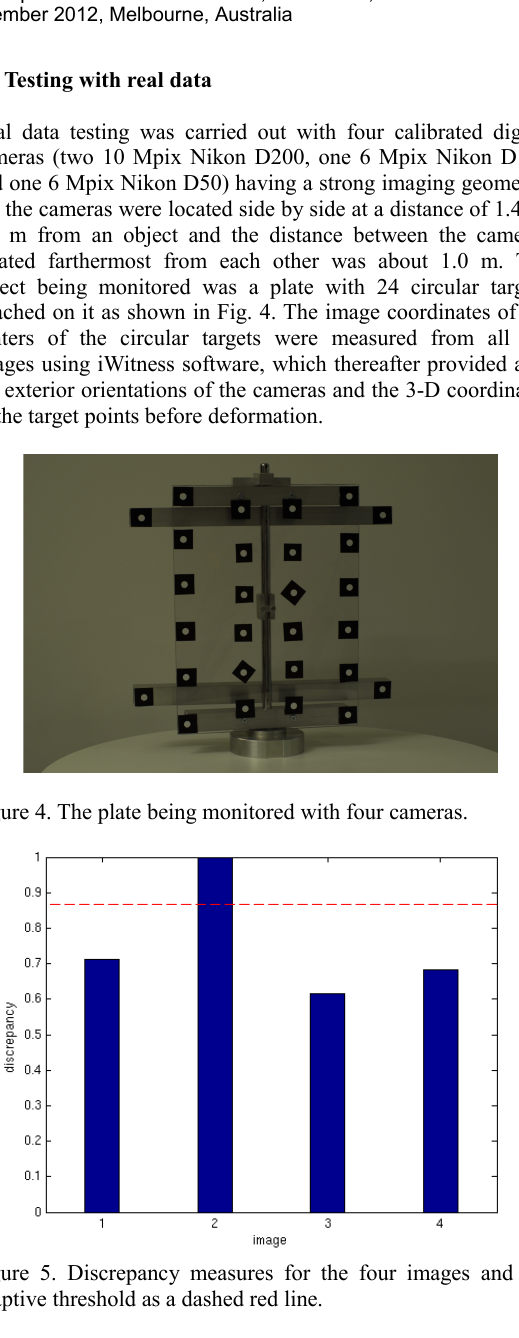
the exterior orientation of which had been